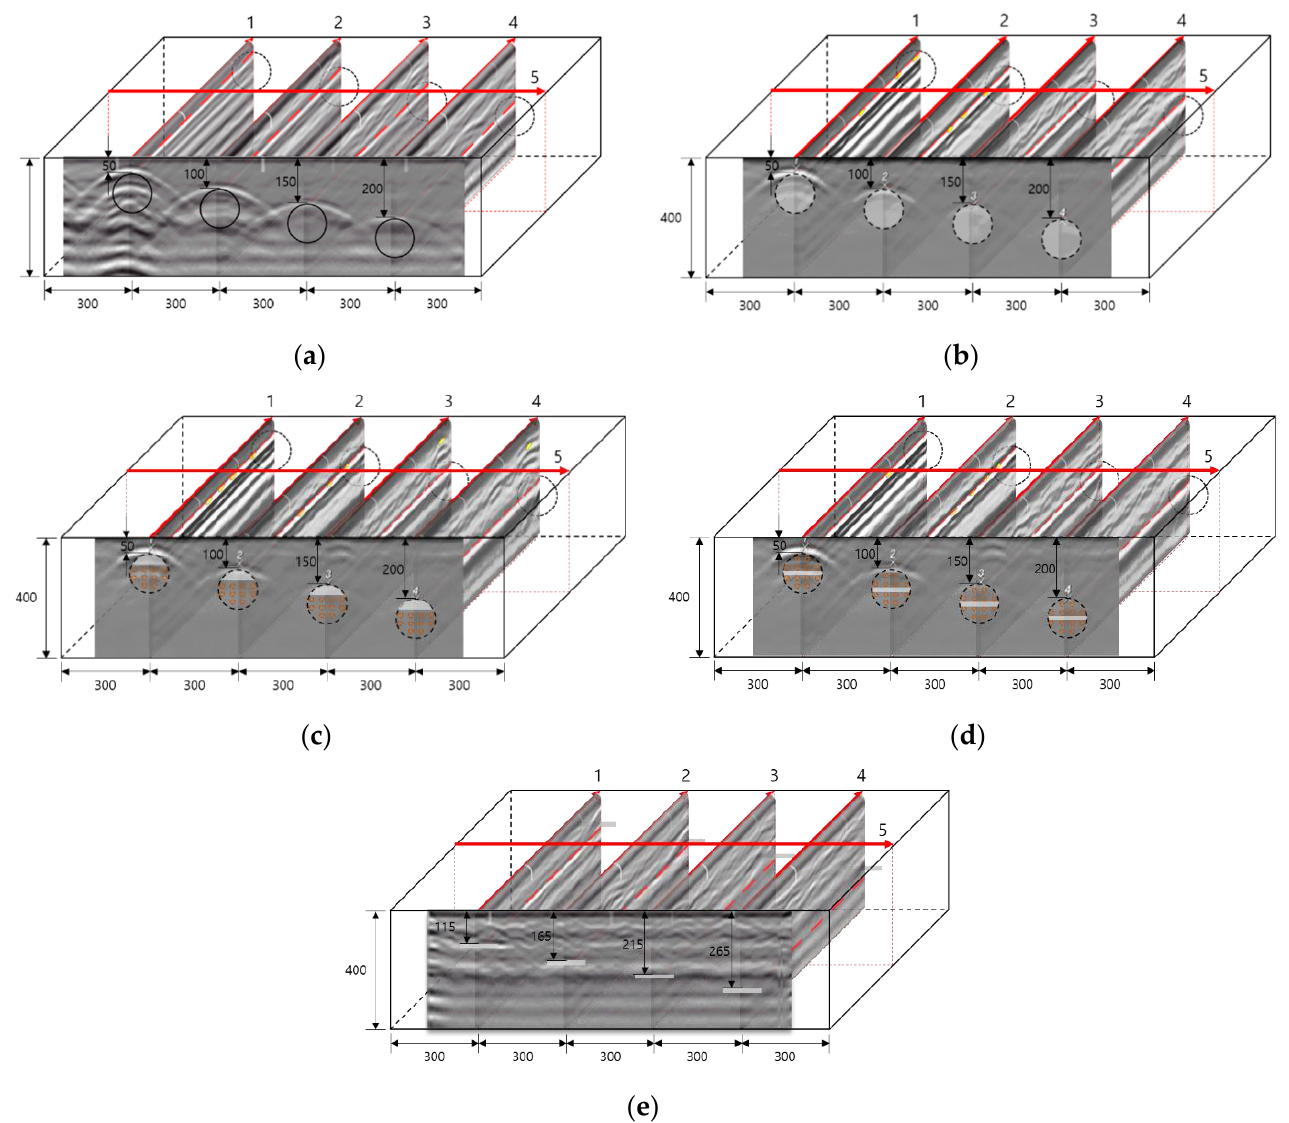
Figure 7. Test results by RC radar. Slabs: ( a ) A; ( b ) B; ( c ) C; ( d ) D; ( e ) E (dimensions in mm).